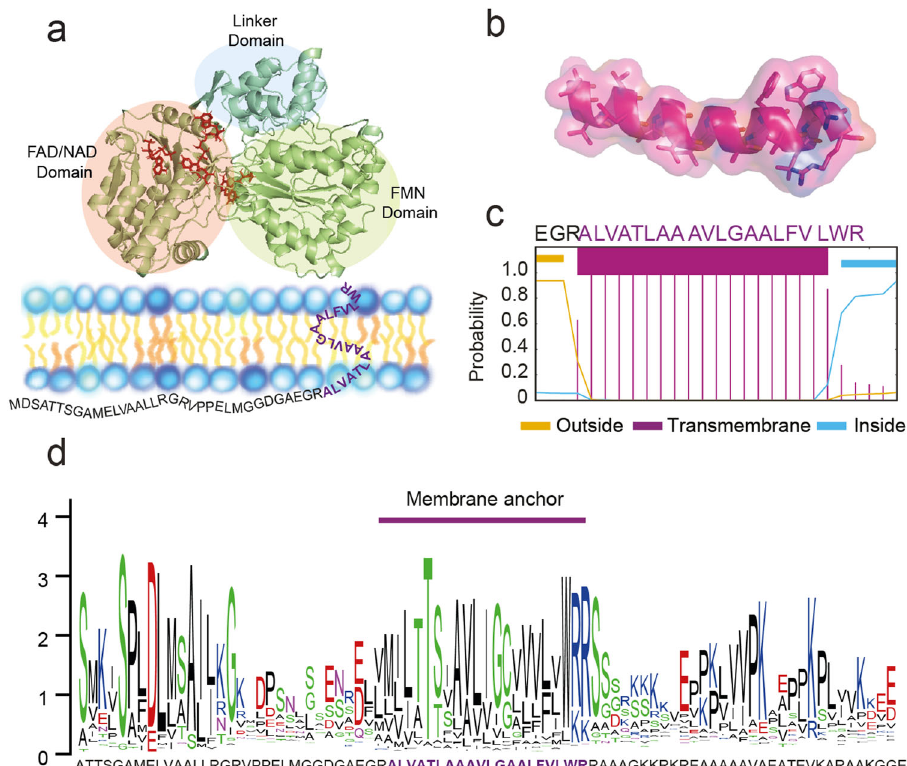
Fig. 1 Membrane-bound Cytochrome P450 Oxidoreductase (POR). a Homology model of POR2b from Sorghum bicolor was performed using the automated online Phyre2 server. The three major domains are highlighted namely FMN binding domain, linker domain, and FAD/NADPH binding domain. The membrane anchor is depicted as the amino acid single letter code. b Structural model of the anchor region predicted by RaptorX, which is a protein structure prediction method based on homology modeling and deep learning. c Transmembrane α -helix prediction for the anchor region of POR2B by TMHMM, powered by a hidden Markov model 66 , with N-terminus (EGR) and C-terminus (RAAA). Source data available as Supplementary Data 3. d WebLogo representation of the conservation of POR sequences depicted from multiple sequence alignment of 278 homologous (Supplementary Fig. 1, 67 ). The anchor region consensus sequence is MILTTSIAVLIGCVVVLVWR. The difference between the maximum possible entropy and the entropy of the observed amino acid distribution in the anchor region is higher than for the adjacent linker regions, indicating a higher degree of sequence conservation in this part of the protein. Data input for generating the WebLogo is available in Supplementary Data 4.